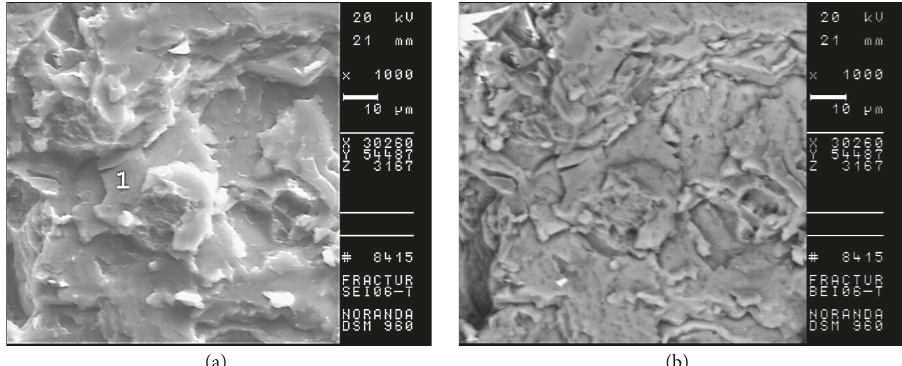
Figure 9: (a) Secondary electron image of the C alloy, 9wt% Al; (b) backscattered electron image of (a).